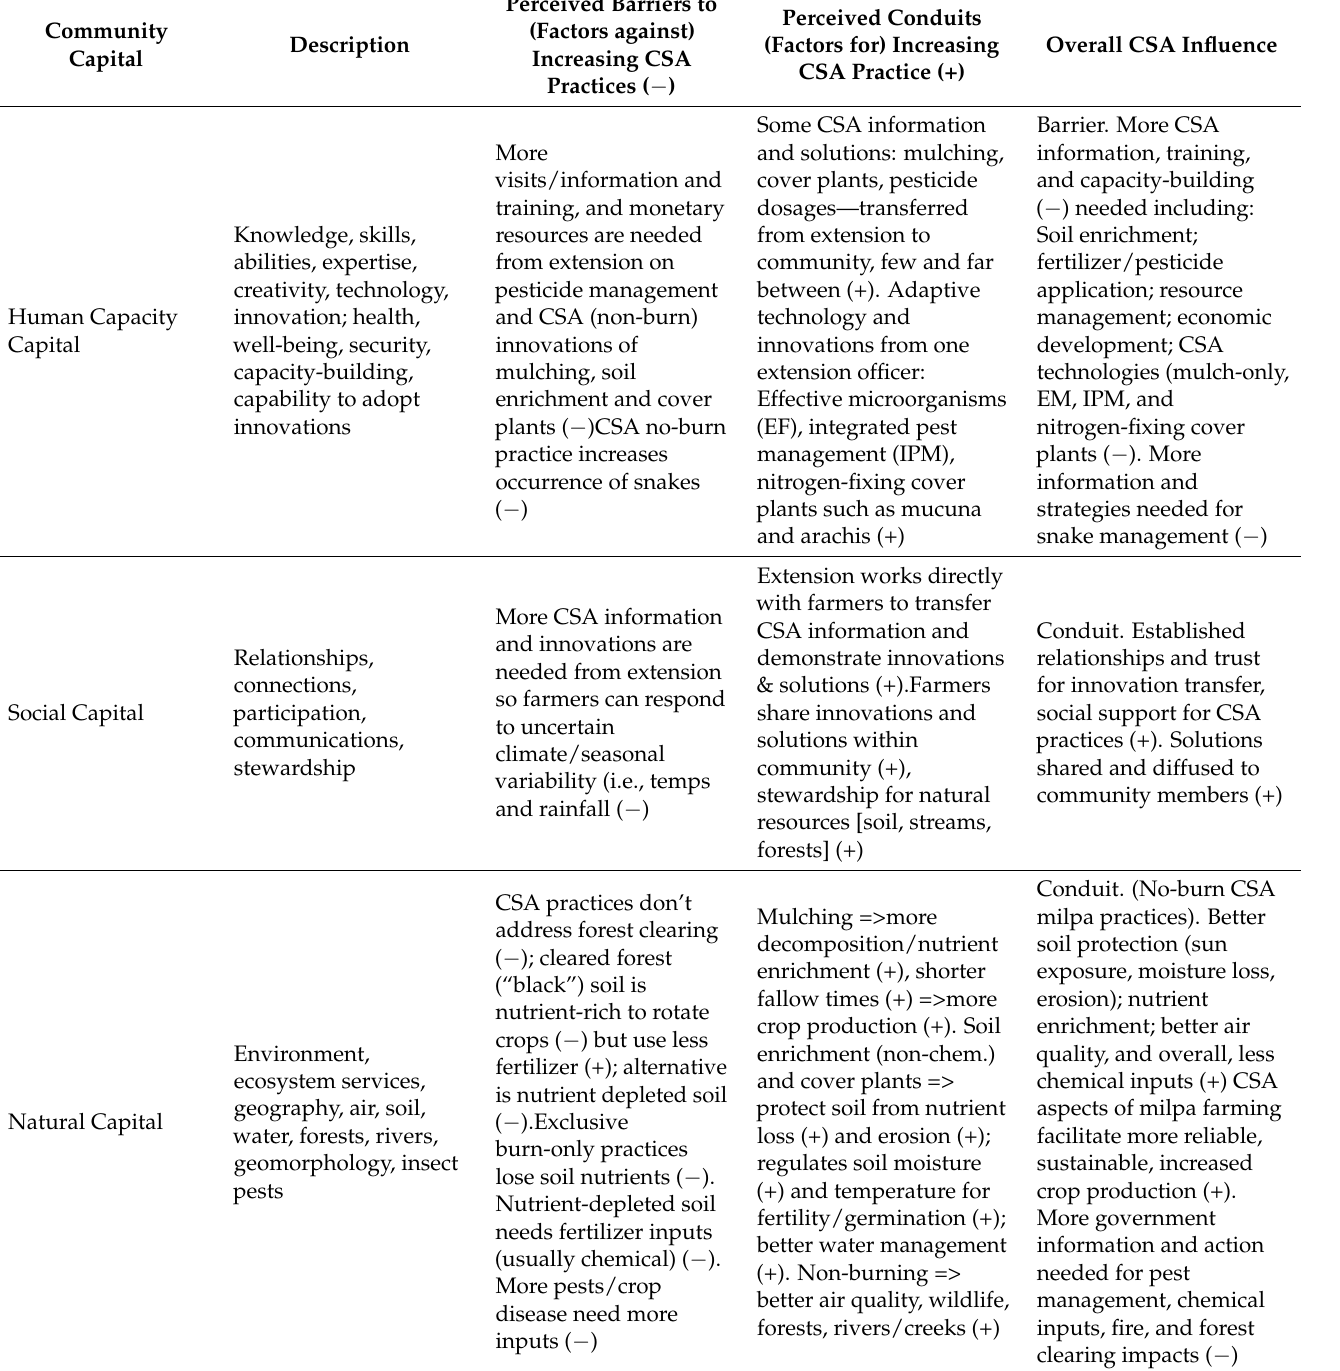
Table 1. Summary of results. A Community Capitals assessment of barriers and conduits which influence the increase of CSA practices of no-burn mulching, soil enrichment, and plant cover in milpa communities in southern